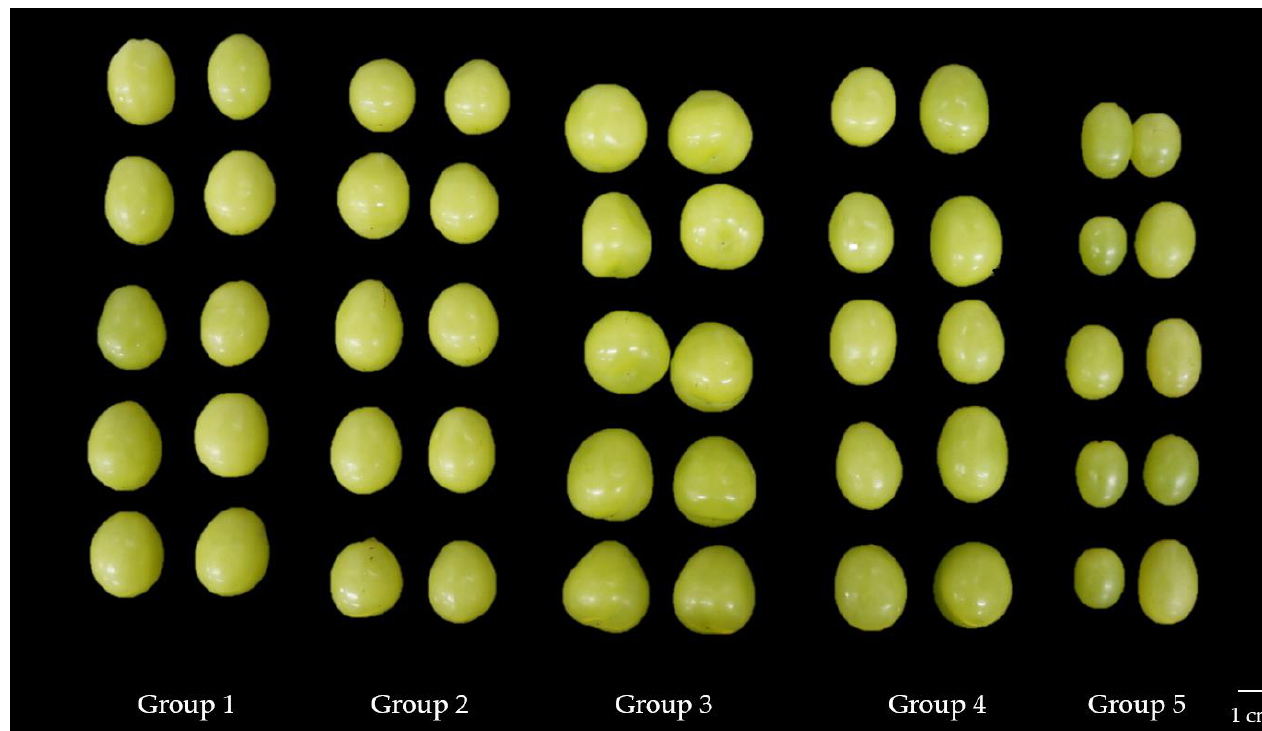
Figure 2. The shape of ‘Shine Muscat’ grape berries at harvest according to the PGR treatment. The combinations of PGR treatments applied at full bloom (F) and 12 days after full bloom (DAFB) are as follows. Group 1: F: GA 3 12.5 + TDZ 2.5, 12 DAFB: GA 3 25. Group 2: F: GA 3 25 + CPPU 5, 12 DAFB: